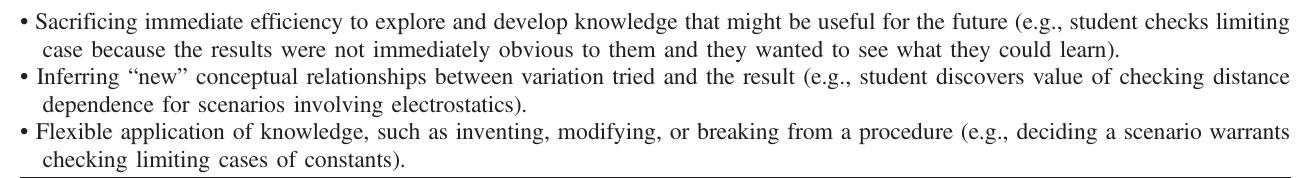
TABLE IV. Indicators of adaptive expertise. (cid:129) Sacrificing immediate efficiency to explore and develop knowledge that might be useful for the future (e.g., student checks limiting case because the results were not immediately obvious to them and they wanted to see what they could learn). (cid:129) Inferring “ new ” conceptual relationships between variation tried and the result (e.g., student discovers value of checking distance dependence for scenarios involving electrostatics). (cid:129) Flexible application of knowledge, such as inventing, modifying, or breaking from a procedure (e.g., deciding a scenario warrants checking limiting cases of